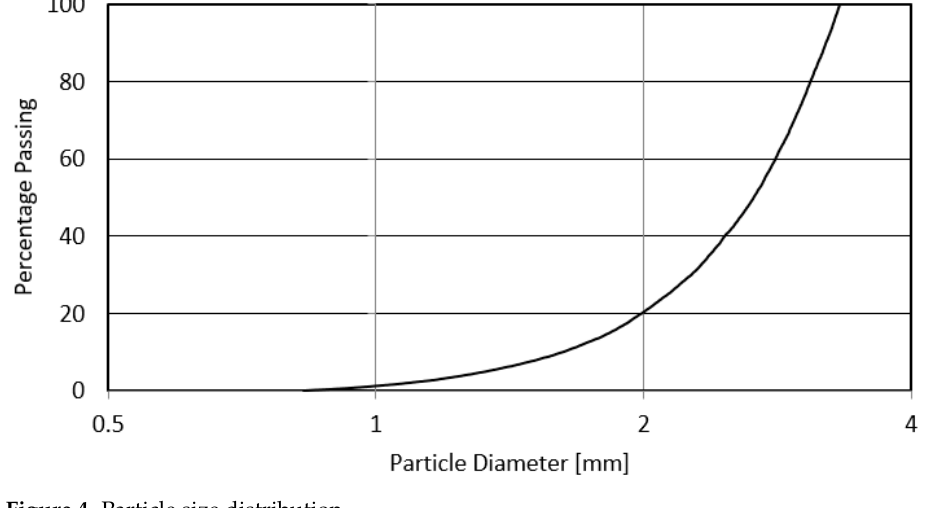
Figure 4. Particle size distribution. Table 1. The initial porosity and micro-mechanical properties of the